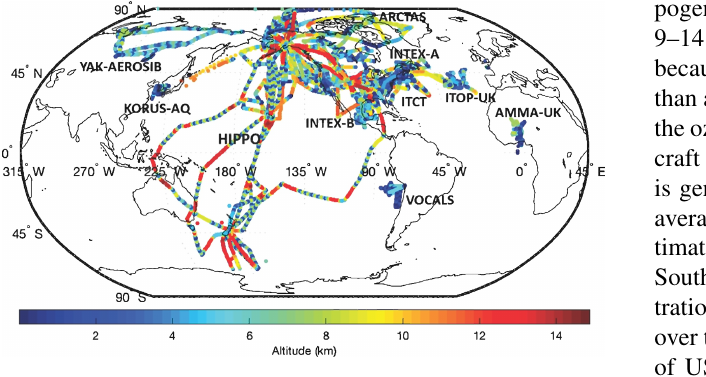
Figure 1. Flight tracks of the campaigns with the altitude of the corresponding